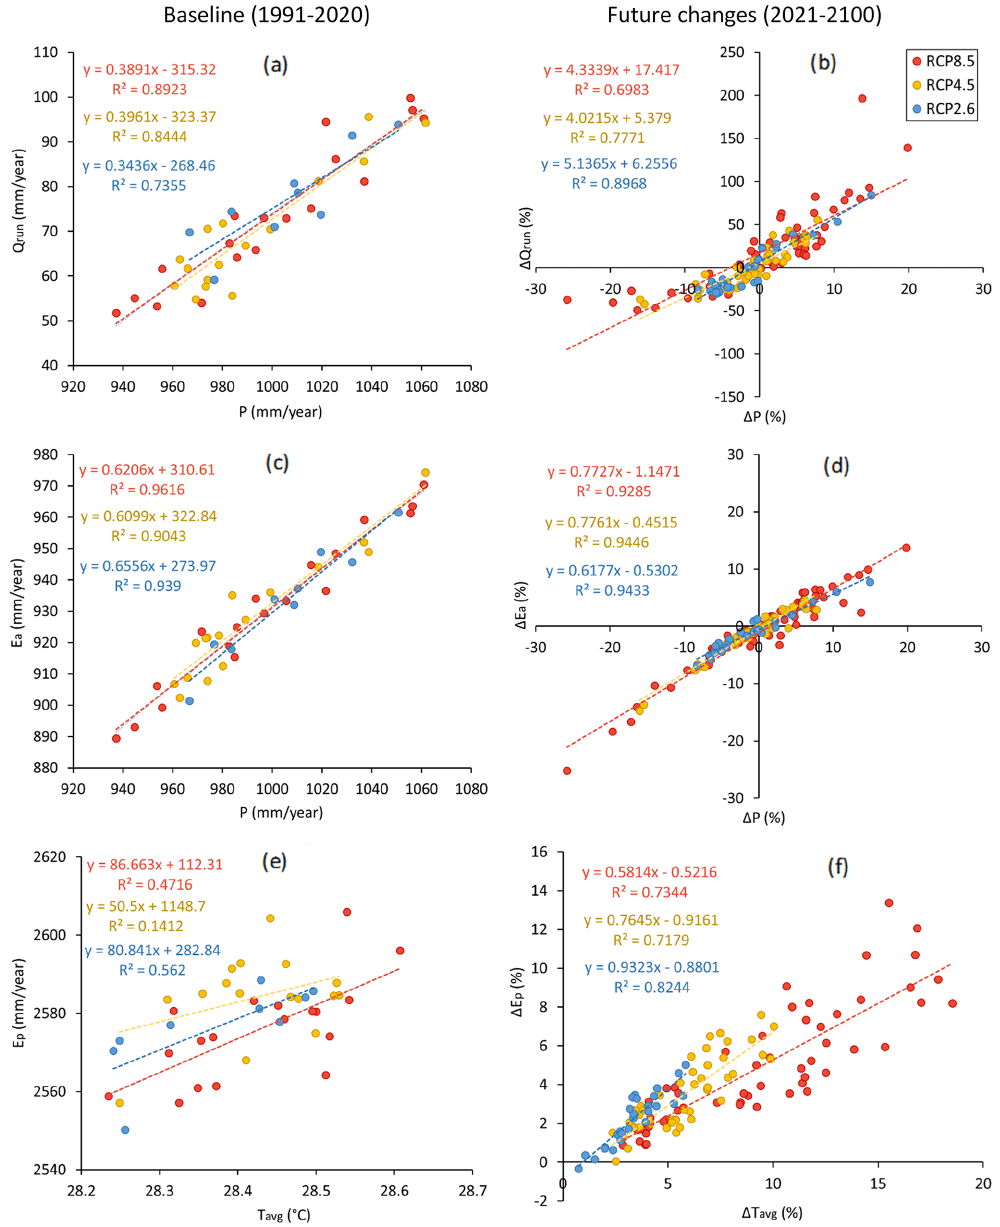
Figure 14. Climate sensitivity of hydrological processes in the VRB over the historical period (a, c, e) with the associated future changes (b, d, f) . The coloured dots represent RCM–GCM combinations per RCP, and the coloured dashed lines represent the fitted linear